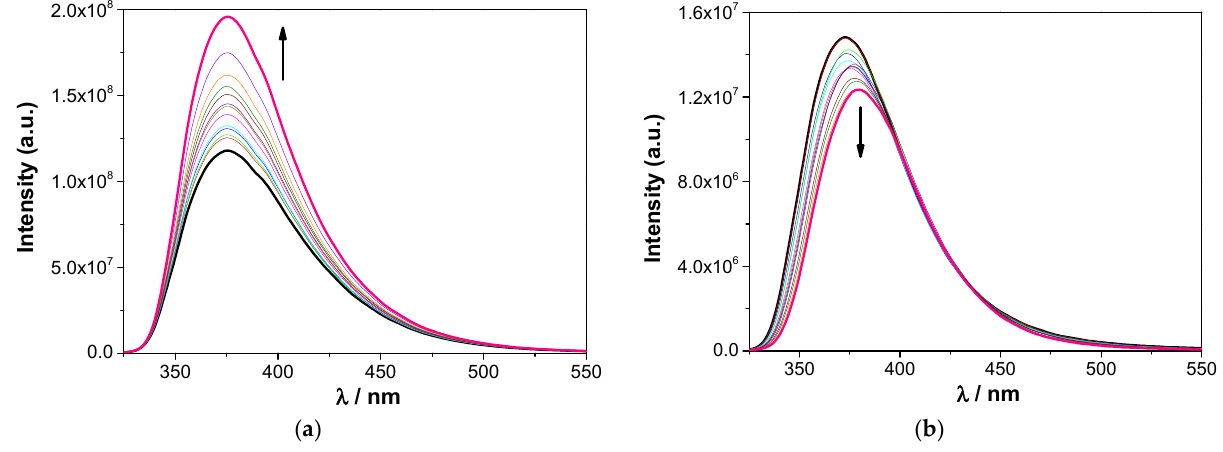
Figure 5. Changes in the emission spectrum of urea 4a (2.0 × 10 –5 M) upon addition of TBA F (up to 10 equiv) in ( a ) CH 2 Cl 2 and ( b ) MeCN. The arrows indicate the effect of increasing amounts of salt. The fluorescence of thiourea 4b could not be studied, as this derivative is unstable upon